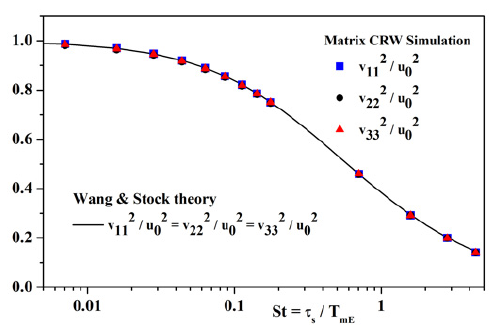
Figure 21. Normalized variance of particle velocity (g = 0).